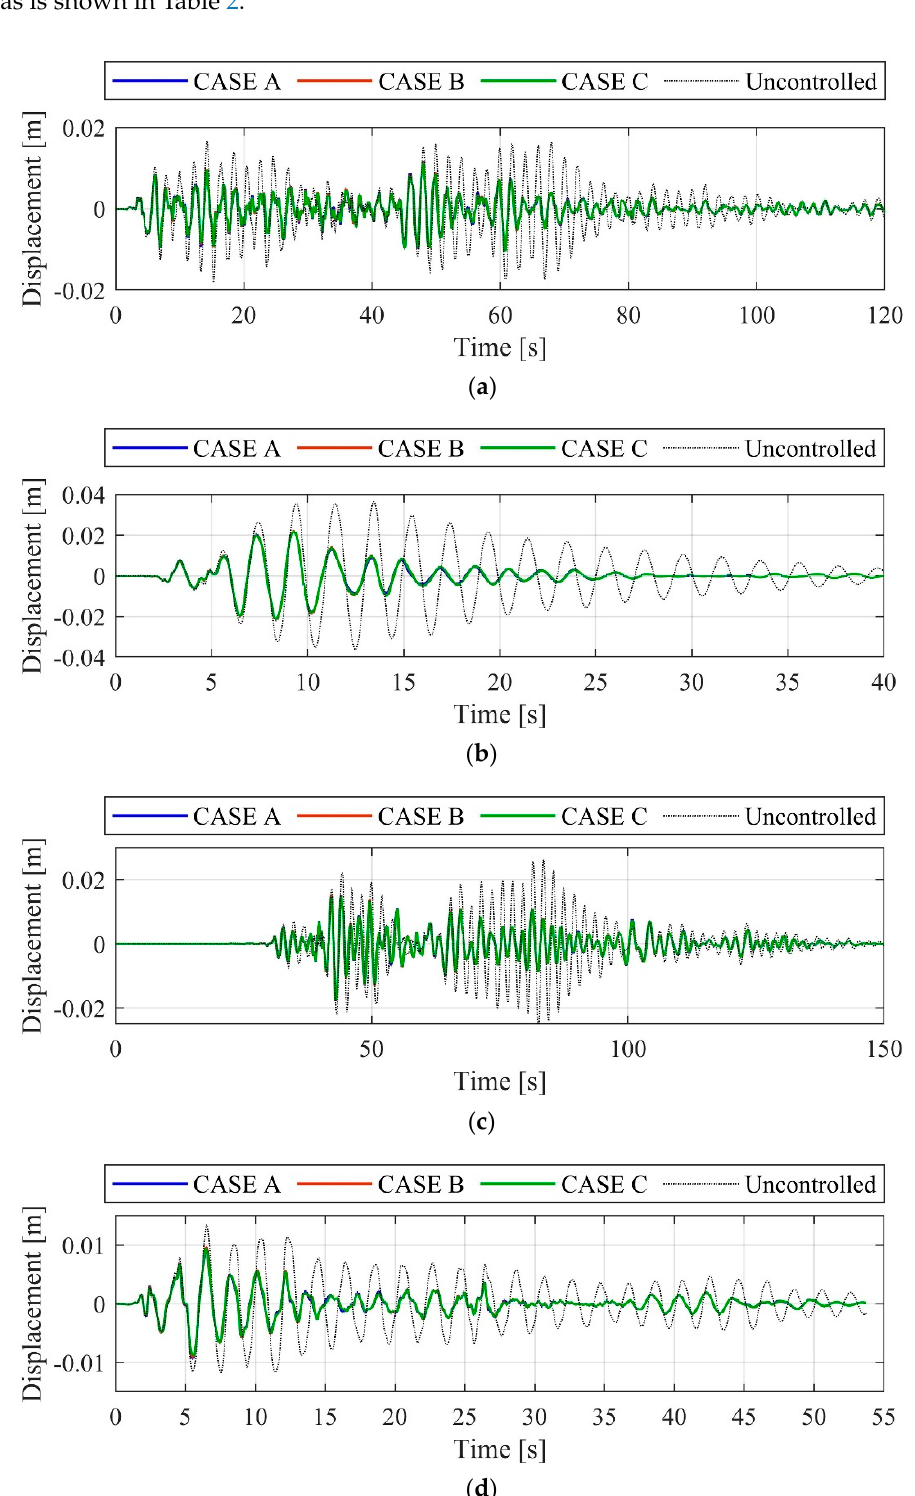
Figure 12. Displacement responses of the fourth layer: ( a ) BCJ-L2 artificial accelerogram; ( b ) Kobe